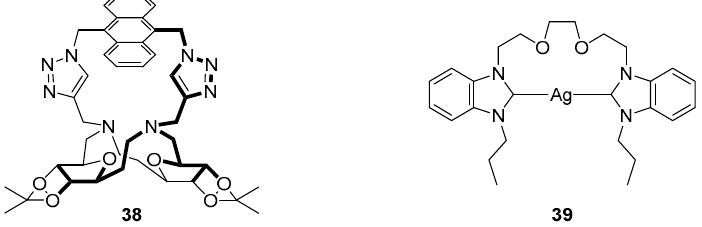
Figure 16. Crown ether anion sensors: anthracenyl derivative bis-triazole 38 reports HSO 4 − binding with a significant increase in the anthracene emission [114], while N -heterocyclic carbene (NHC) complex 39 responds selectively to I − with quenching of an emission band at 362 nm [116].